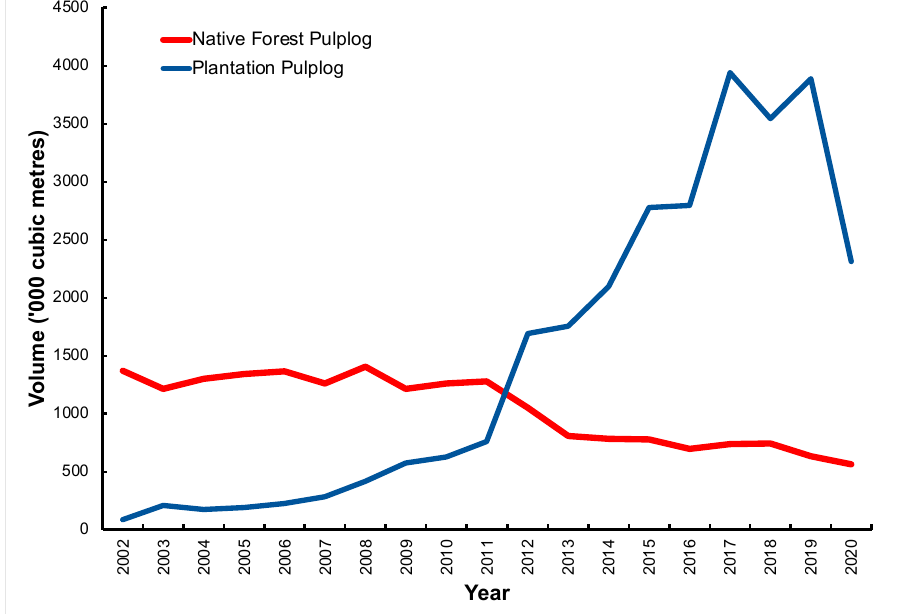
Figure 4. Volume of hardwood pulp logs from native forests and plantations (derived from ABARES 2021 data).